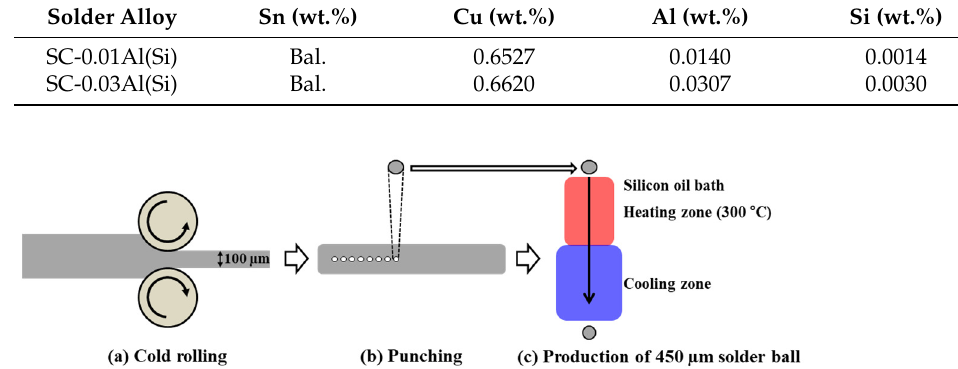
Table 1. Composition of the manufactured solder alloys.